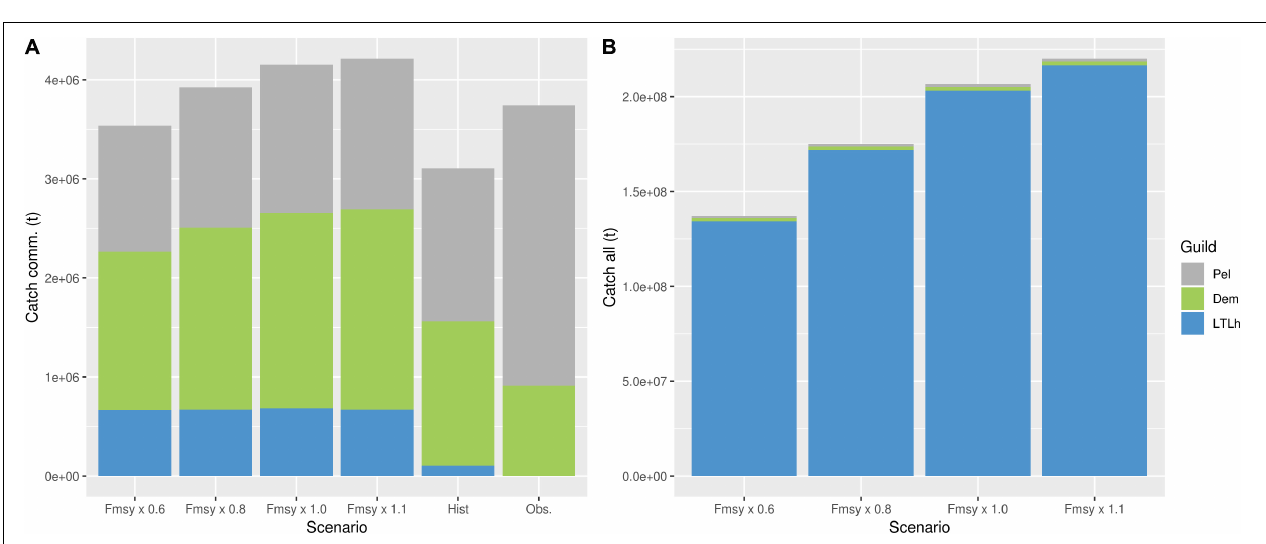
FIGURE 5 | Ecological indicators for the four scenarios investigated. (A) Results from the scenarios when only commercial species are harvested. (B) Results from the scenarios when all components (commercial + five additional components) are being harvested. For the four scenarios, gs is the global sustainability (gray), ls is local stewardship (blue), ne is national enterprise (orange) and wm is world market (green). In addition, the indicators from the historical period of the simulations are added to the figures, for comparison between future projections and historical results. Biomass indicators are grouped on the left and catch indicators on the right side of the radar charts. All values increase from the center of the radar plot, to the edge.